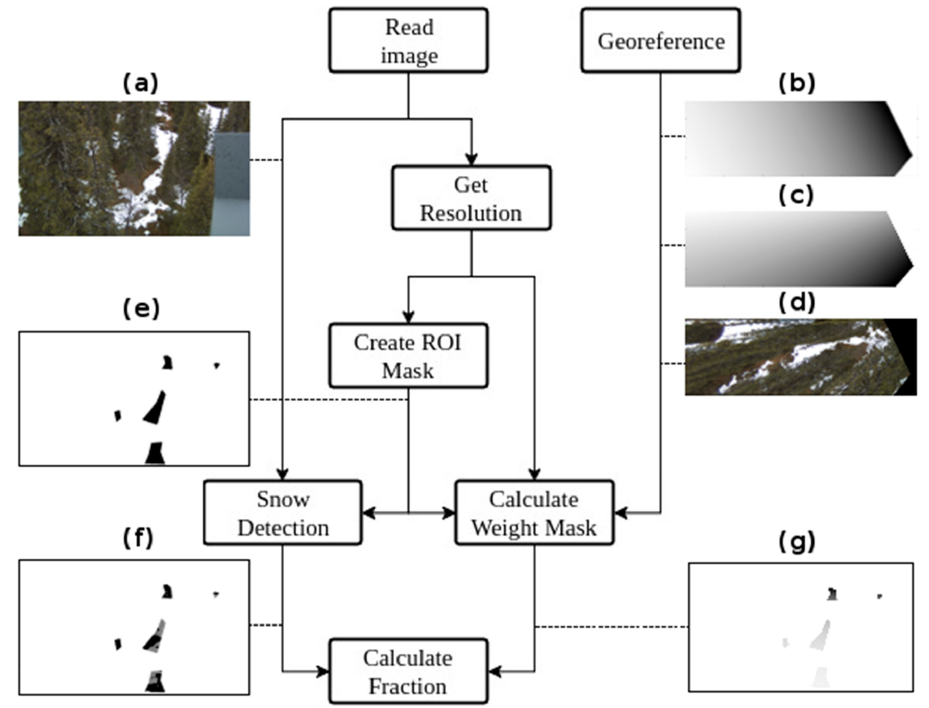
Figure 7. Main steps of calculating fractional snow cover for a single image: ( a ) Original image; ( b ) Corresponding y coordinates of the image on the spatial grid; ( c ) Corresponding x coordinates of the image on the spatial grid; ( d ) Georeferenced image on the spatial grid (for ( b )–( d ), spatial area is cropped according to the ROI.); ( e ) The mask to be applied for the ROI; ( f ) Snow-covered and snow-free pixels in ROI; and ( g ) Weight of the surface area for each pixel in the ROI.